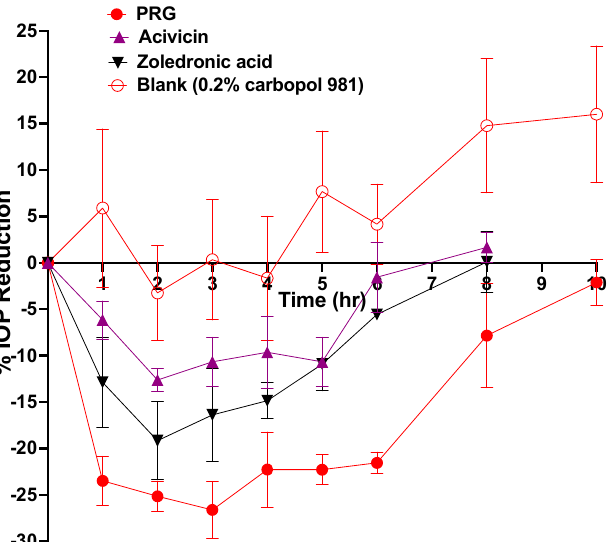
Figure 4. % IOP reduction of DB rabbits ( n = 3) after topical application of 100 µ L of viscous eye drops containing 0.6% w/v of each compound in 0.2% w/v Carbopol 981. The PRG and blank data presented with permission from ACS Nano [10].